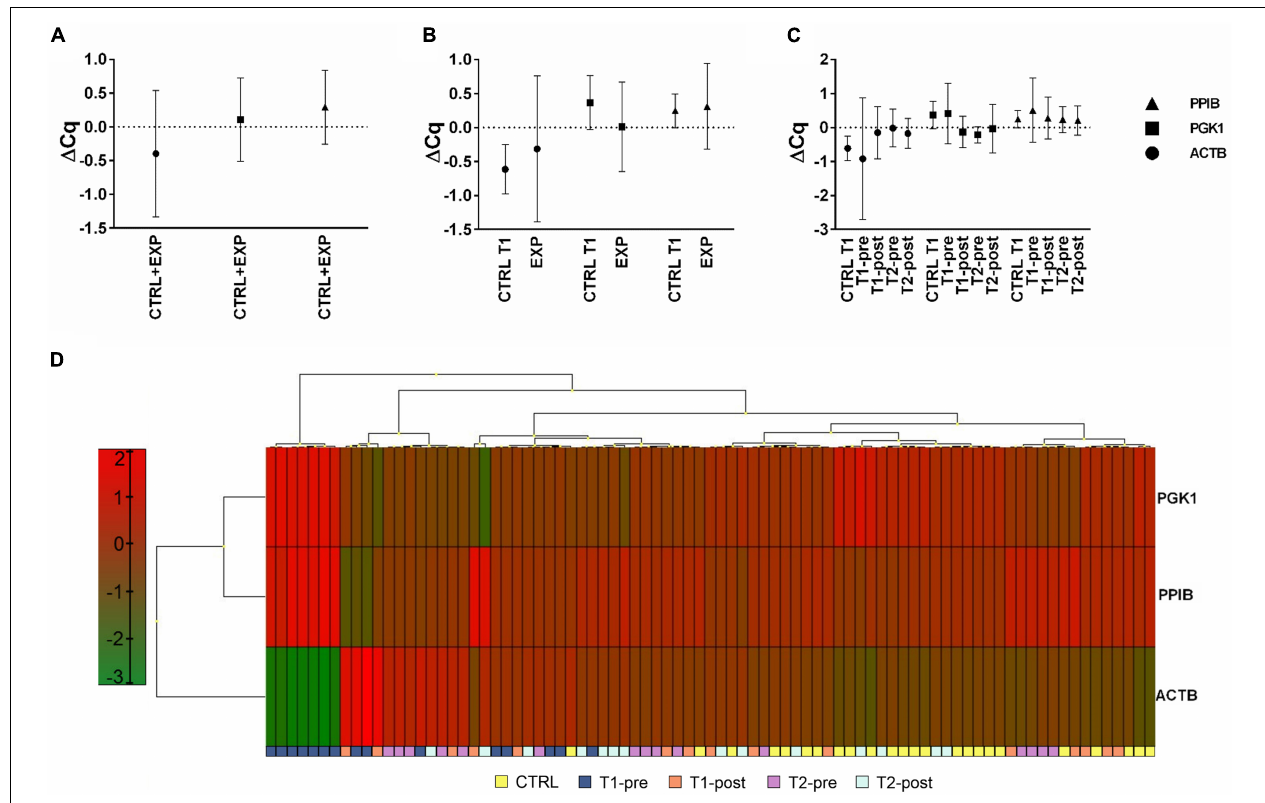
FIGURE 1 | Expression profile of potential housekeeping genes, ACTB, PGK1, and PPIB, in whole blood. Expression profile of the three selected potential reference genes (ACTB, PGK1, and PPIB). Expression level of each potential reference gene was analyzed considering (A) samples from all groups (CTRL+EXP), (B) samples from the EXP (T1-pre, T1-post, T2-pre, and T2-post), and CTRL groups separated, and (C) samples from each time-point separated. (D) Heat-map of the expression profiles of ACTB, PGK1, and PPIB, from each group (CTRL, T1-pre, T1-post, T2-pre, and T2-post). Different colors represent differential gene